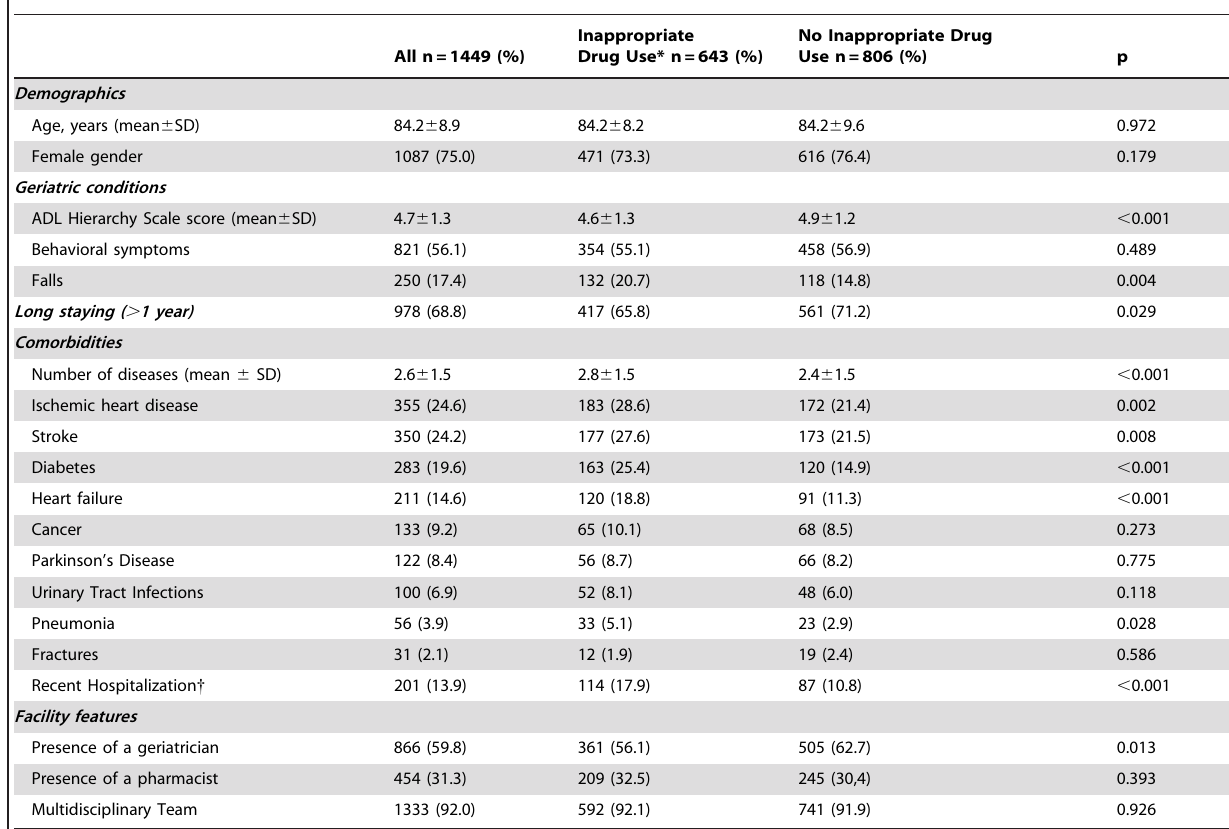
Table 1. Sample characteristics according to inappropriate drug use.